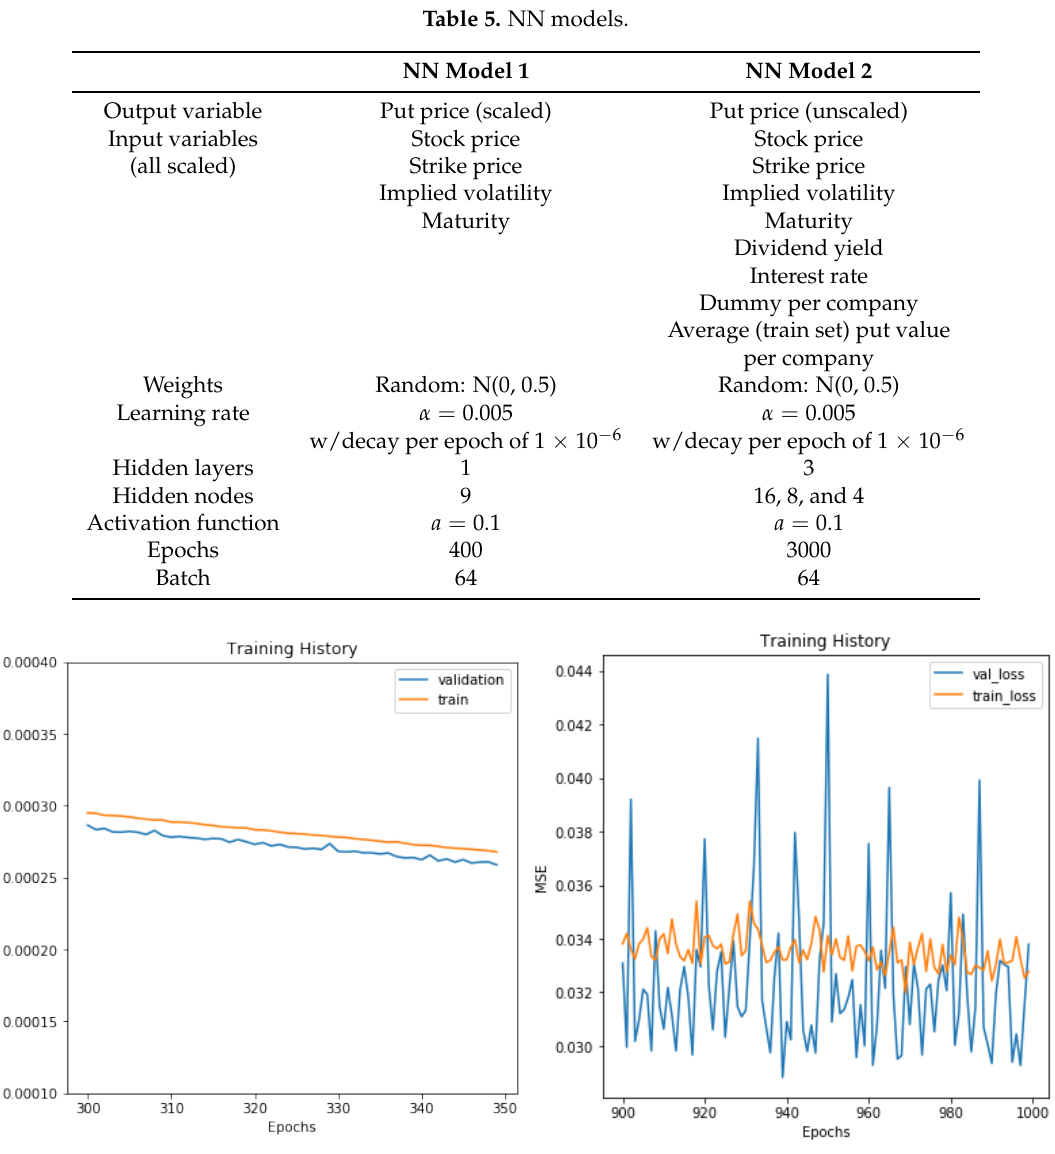
Figure 9. NN models’ learning